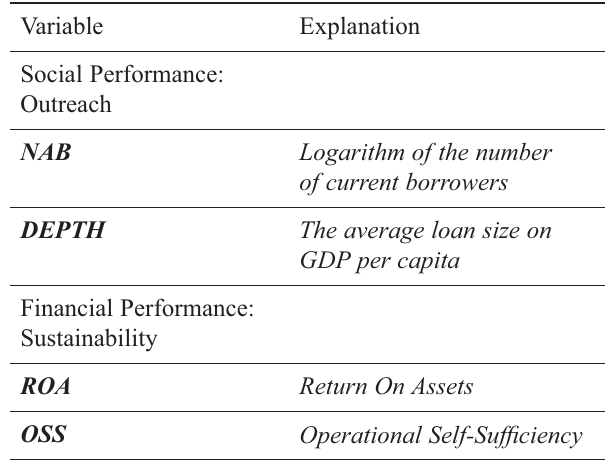
Table 1. Defi nitions of dependent variables used in